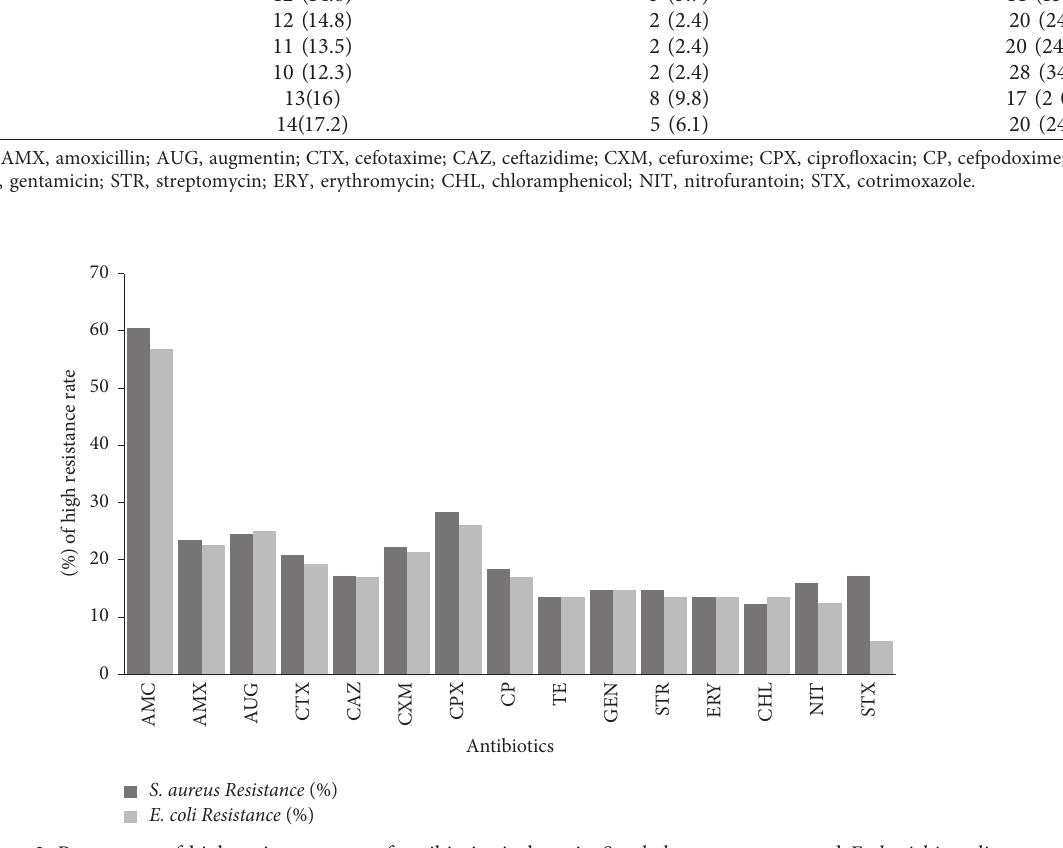
Figure 2: Percentage of high resistance rate of antibiotics isolates in Staphylococcus aureus and Escherichia